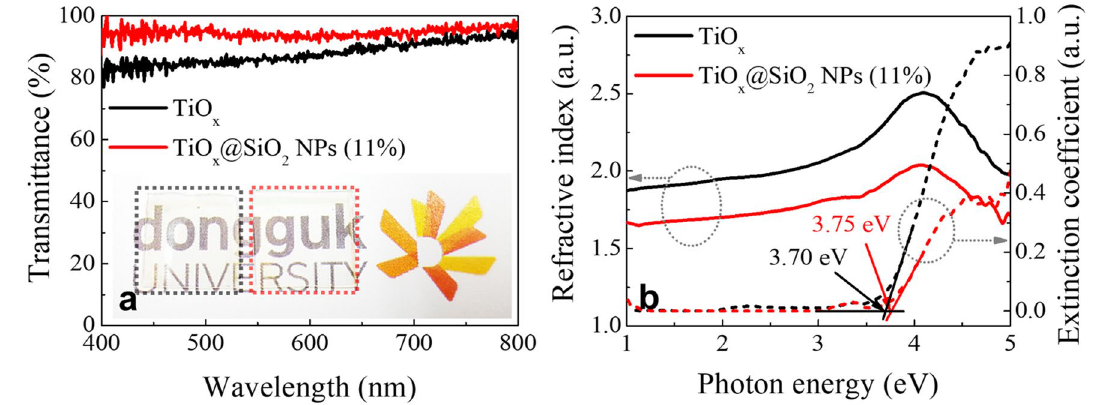
Figure 3. ( a ) Optical transmittance and ( b ) optical constants of the TiO x and TiO x @SiO 2 NPs films. Inset shows the high transparency of the TiO x (left) and TiO x @SiO 2 NPs (right) switching